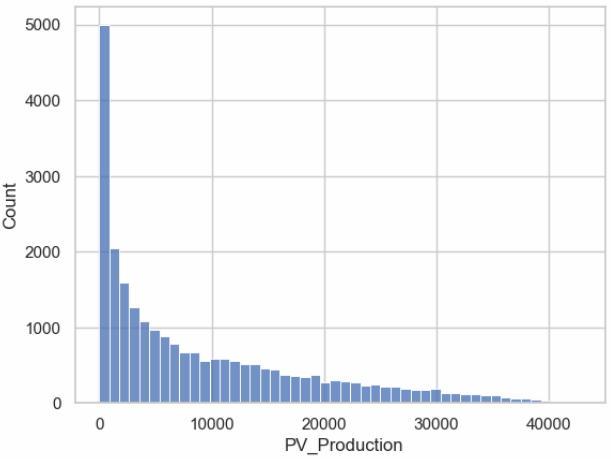
Figure 4. Histogram of the PV production.